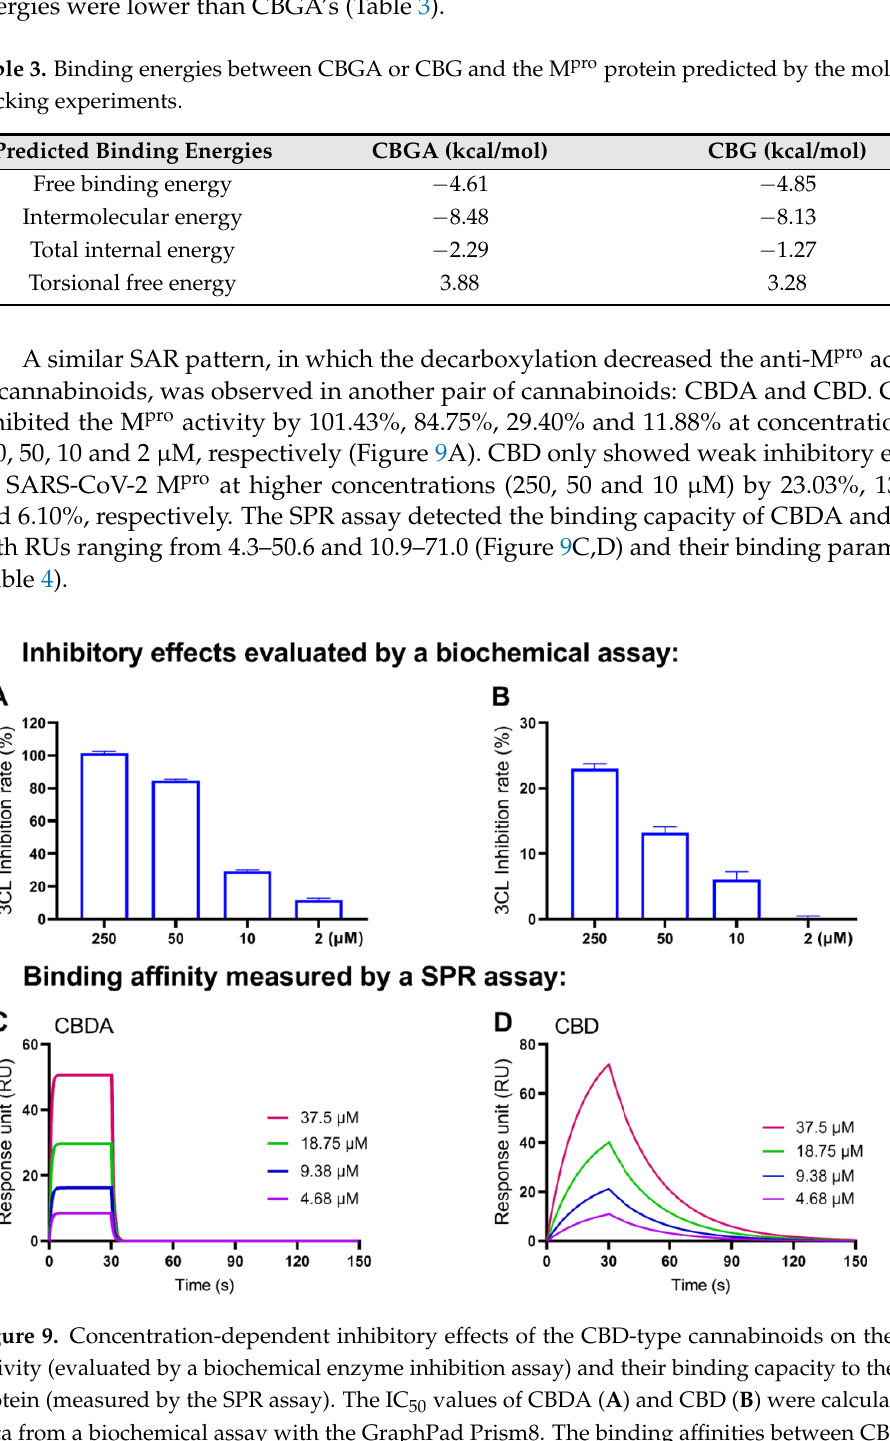
Data from the molecular docking experiments illustrated the potential impact of the decarboxylation of CBDA on the ligand – protein interactions (Figure 10). CBDA and CBD both have several common molecular forces (such as van der Waals, hydrogen bond, al- kyl, and Pi alkyl) that contributed to the ligand-protein binding. CBDA and CBD formed hydrogen bonds at the same locations on chain A (e.g., Asn 142 and His 164, and Glu 166, respectively; Figure 10C,D). The molecular docking study predicted that this pair of com- pounds had a similar binding capacity whilst CBD had lower binding energies than CBDA (Table 5).